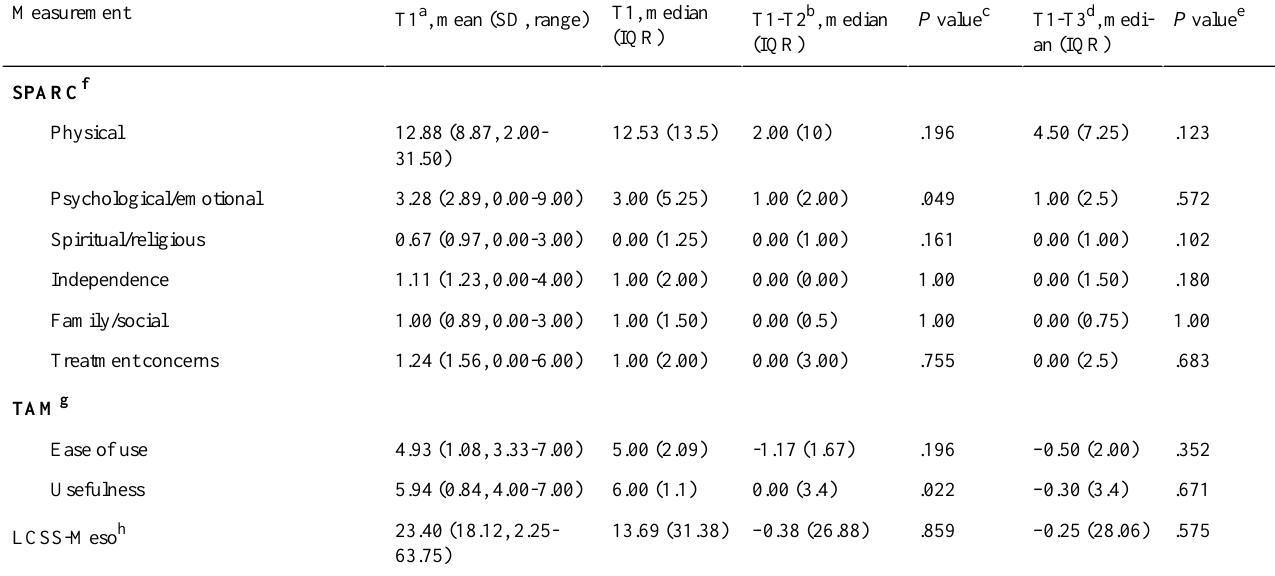
Table 2. Patient-reported